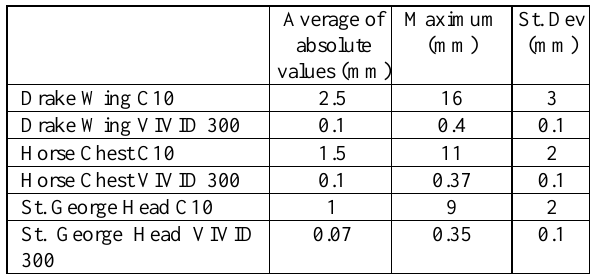
Figure 10. The deviations points-model (from the VIVID 300 scans) for the chest of the horse